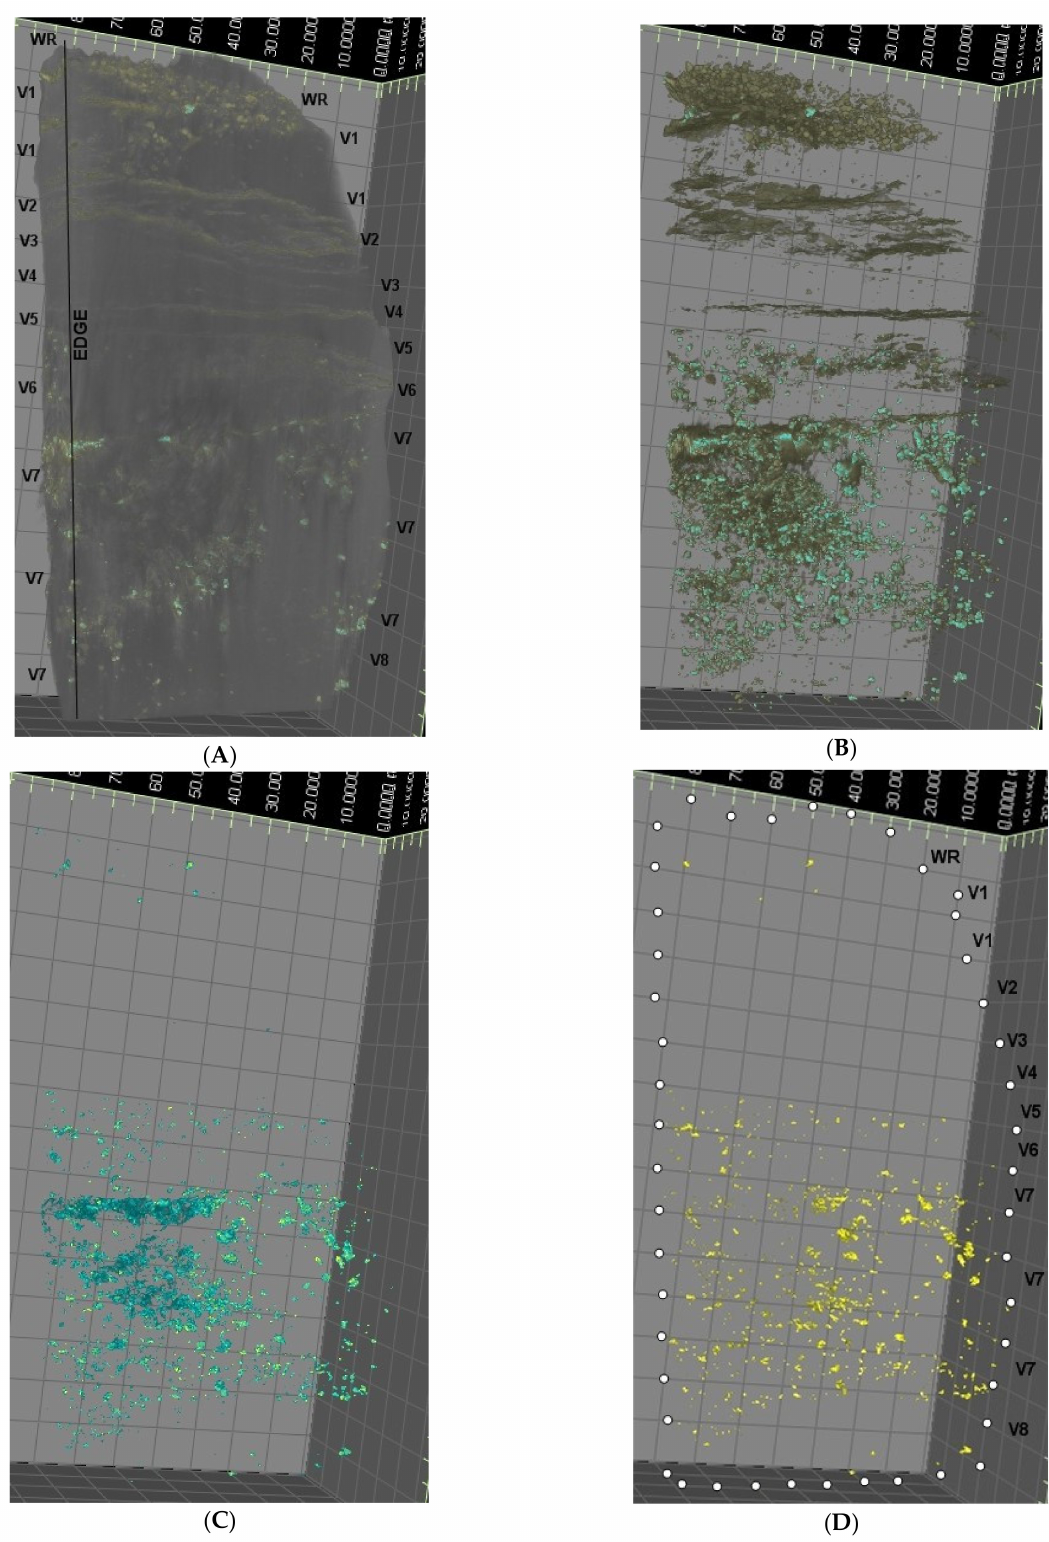
Figure 12. Images derived from XCT scans of sample B5. Images show a slightly oblique view of the face illustrated in Figure 9 and shows the cut side of the sample slab that is not visible in Figure 9. The background grid is part of the sample co-ordinate system, grid spacing is 10 mm. ( A ) Sample surface showing position relative to grid and locating veins (V) and wallrock (WR). ( B ) Full volume of lower density sulphides (arsenopyrite—brown). ( C ) Full volume of high-density sulphide (galena—blue) with gold (yellow). ( D ) Full volume of gold (yellow) with sample outline shown by